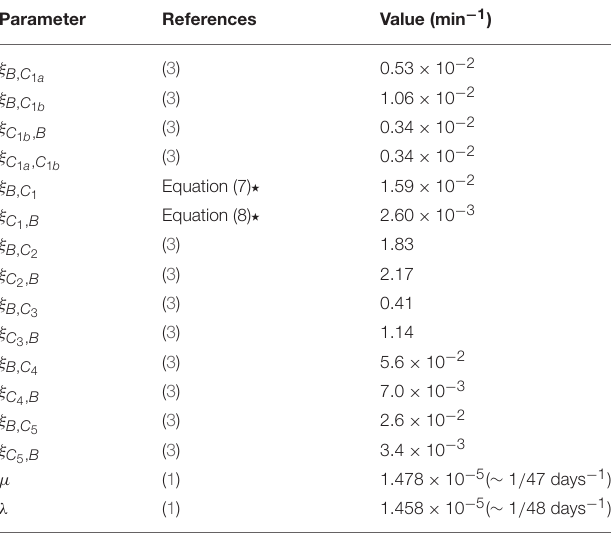
TABLE 1 | Parameter values considered in the numerical study. Blood and M = 5 additional spatial compartments as in Ganusov and Auerbach ( 3, Figure 2).